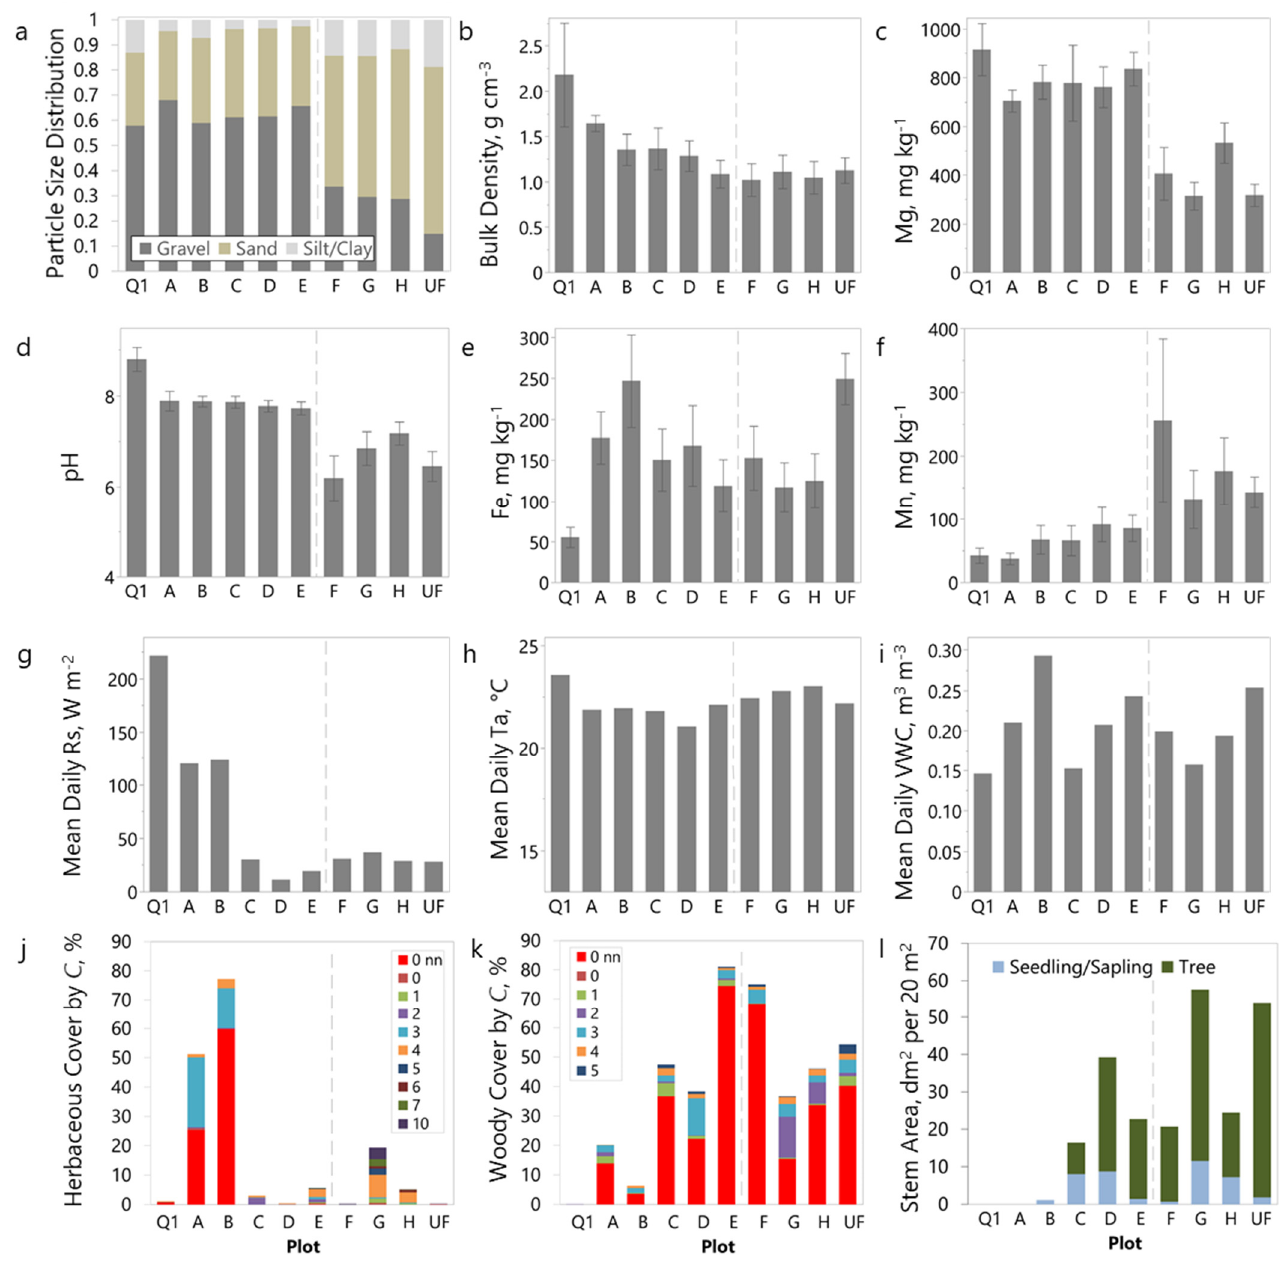
Figure 3. Select soil physical ( a , b ) and chemical ( c – f ) characteristics, microclimate ( g – i ), and vegeta- tion composition characteristics ( j – l ) in eight plots of a 70-year-old abandoned quarry (Plots A–E: quarry floor, F–H: quarry top), a recently decommissioned reference quarry (Q1), and an urban forest reference site (UF) in Jefferson City, Missouri, USA. The vertical dashed line separates quarried surface (left) and non-quarried surface (right). Error bars, if shown, represent 1 SD (n = 20 quadrats). Microclimate data ( g – i ) are shown for the growing season (1 May–30 September); error bars are omitted as they would show temporal variation that was almost identical between sites. Rs—